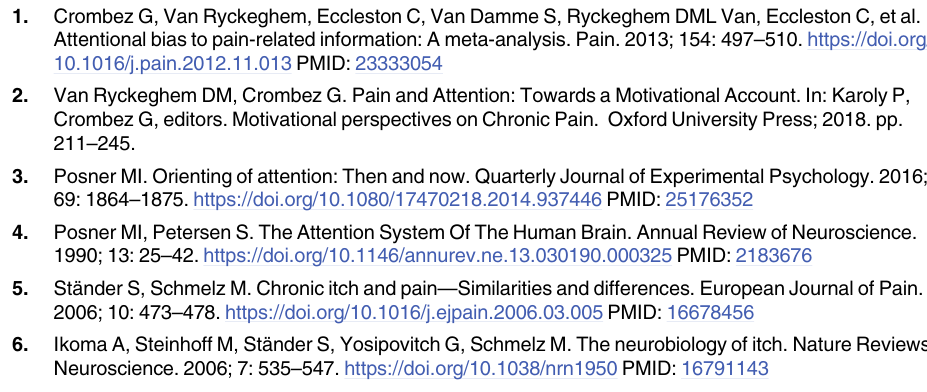
S1 Fig. QQ-plot of the residuals of Model 1 for the reaction times outcome of the sublimi- nal dot-probe task for itch. Inspection of the residual distribution of this QQ-plot to assess model fit and potential bias shows that the fitted models were more accurate for lower values, while being slightly biased upwards for higher values. However, inspecting the QQ-plot of Model 3 (not shown here, but similar to the QQ-plot of Model 1) with more sources of infor- mation, even after adding scores of the awareness check and control neutral picture type (skin vs. object), could not reduce the observed small bias for higher values. Note . Because all QQ- plots for all the different models are similar, this one is shown as an example for all described models in this